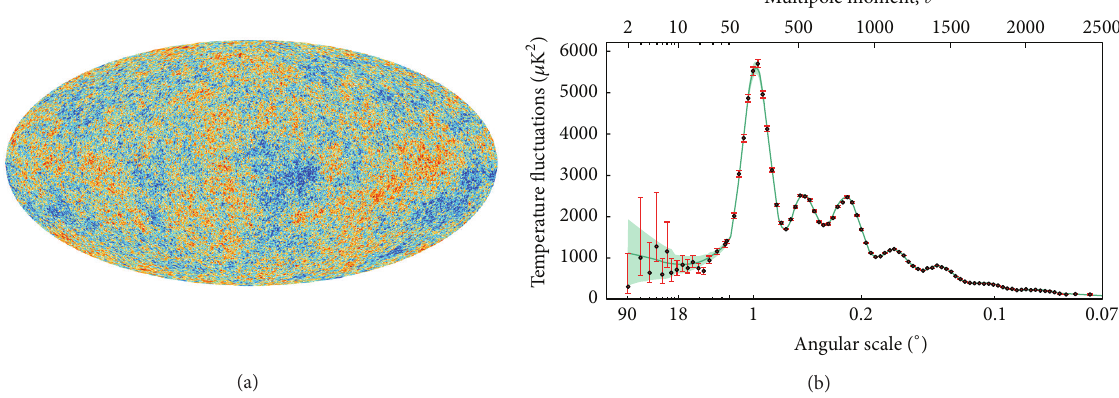
Figure 8: Planck all-sky map of the intensity of the cosmic microwave background radiation is shown in (a). (b) is an analysis of its angular structure and multipole